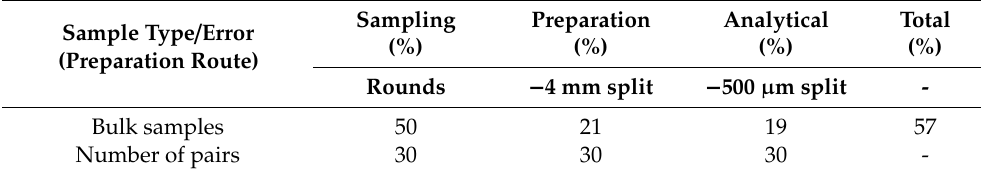
Table 21. Bulk sample head-split duplicate pair